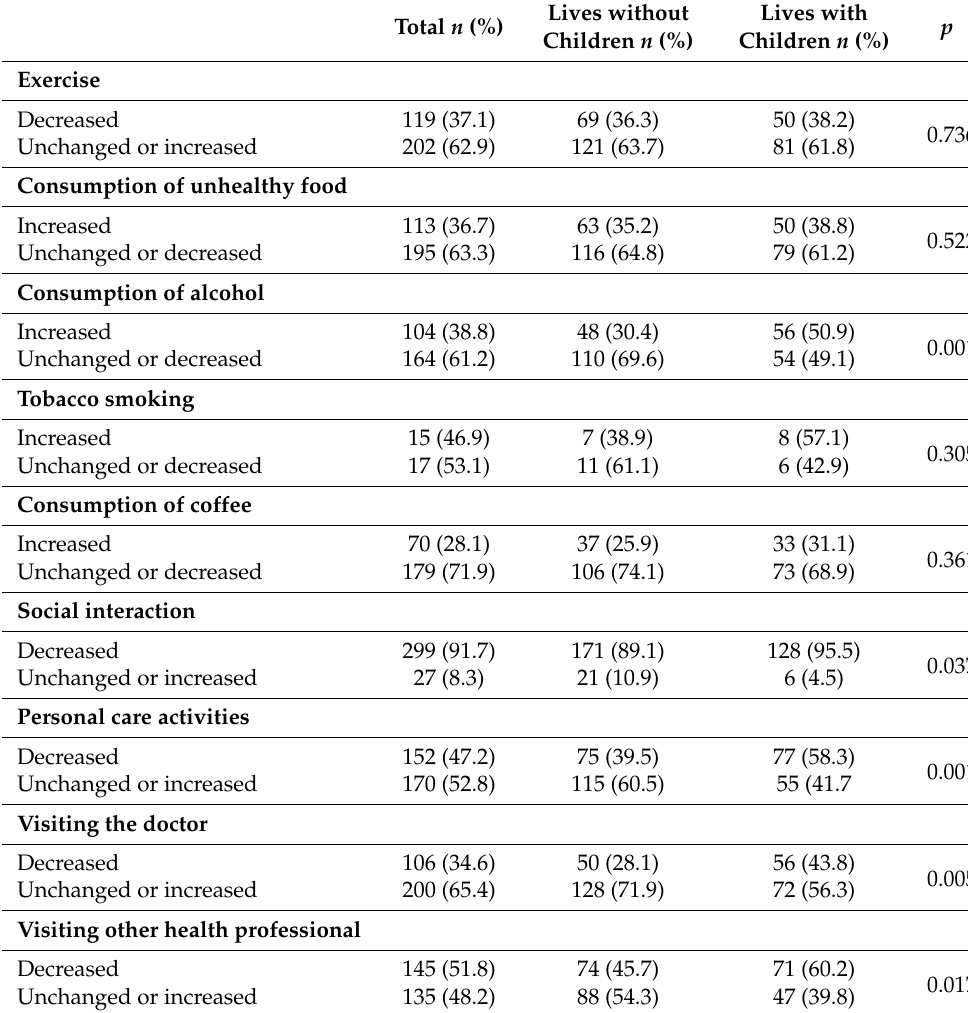
Table 2. Changes to behaviour among females residing in rural areas with or without children.